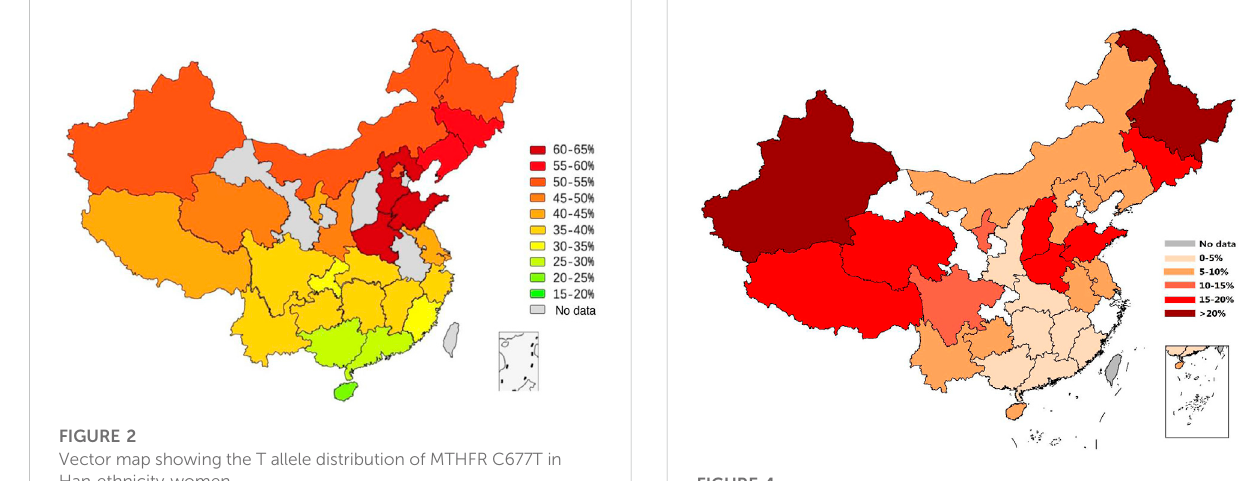
FIGURE 4 Vector map showing the distribution of gestational hypertension-caused deaths in Chinese women in 2020.